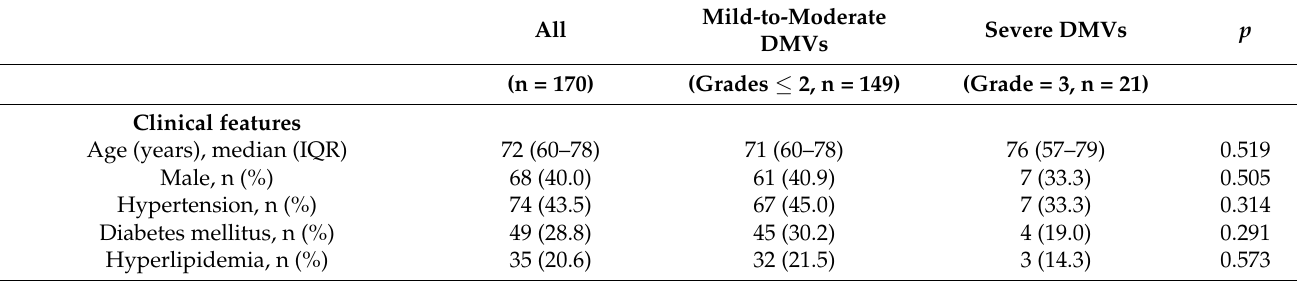
Table 1. Baseline information and differences of variables between the two DMVs grading groups.